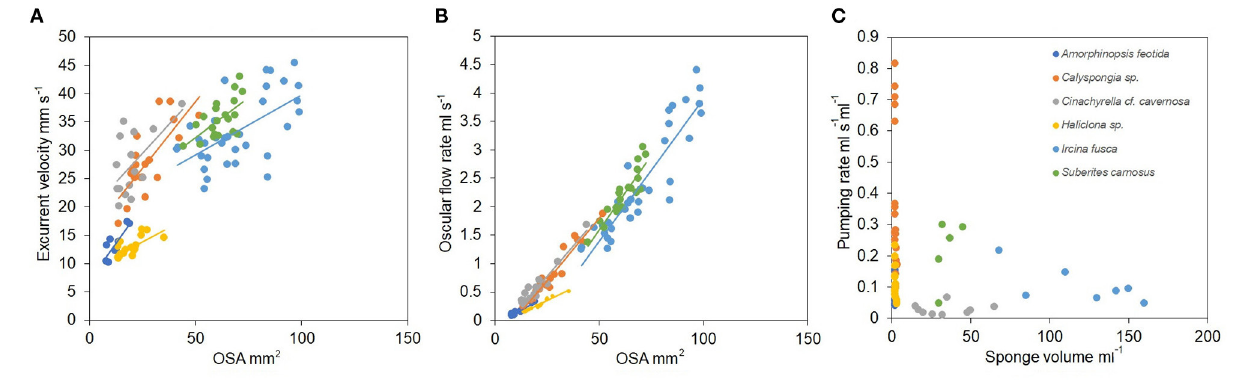
TABLE 2 | The relationship of excurrent velocity and oscular flow rate with the oscular cross sectional area of the studied sponges assessed with linear regression. Species